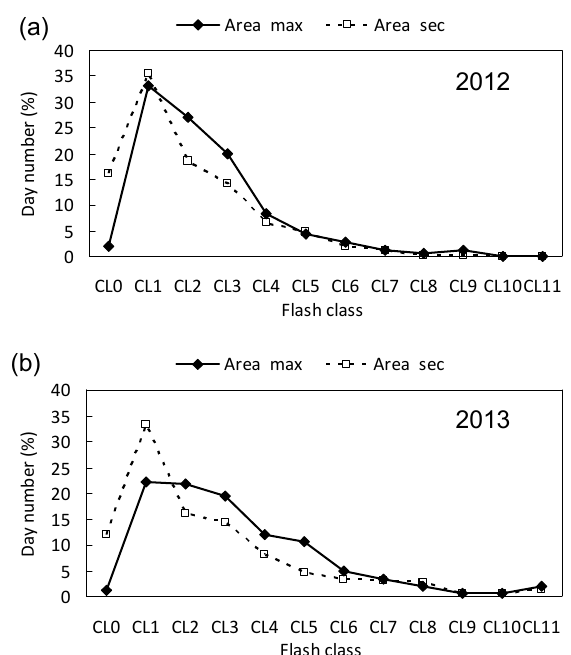
Figure 4. Distribution of the number of days (% of the annual num- ber of days) versus the classes of flash number in both areas: (a) for 366days in 2012 and (b) for 362days in 2013.